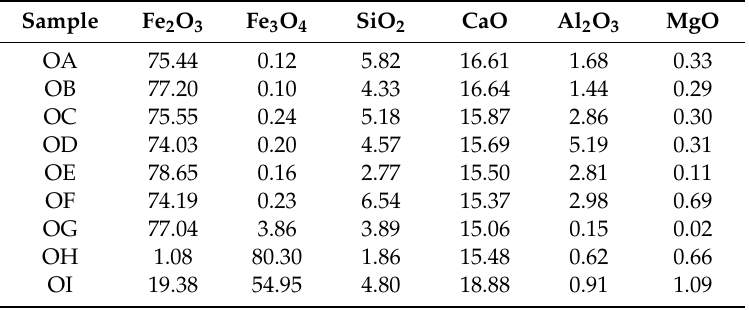
Table 2. Composition of the samples used in calculation with Factsage